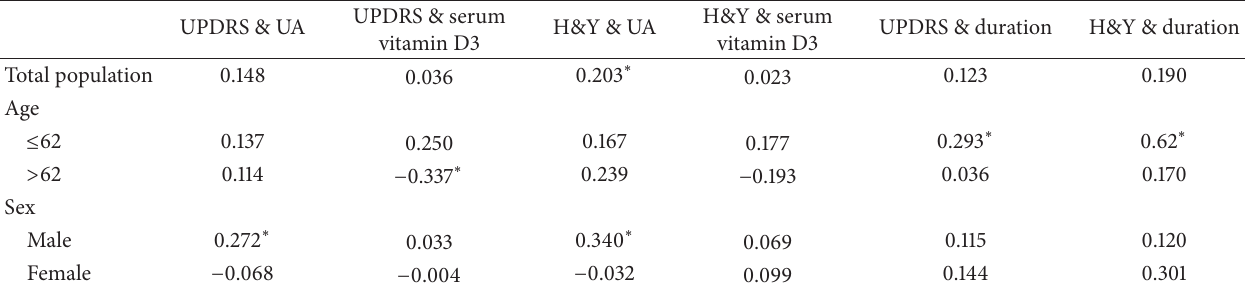
Table 3: Distribution of Hoehn and Yahr levels in different levels of UA at two levels of serum vitamin D3 in total study samples. Hoehn and Yahr categories 𝑃 Category 1